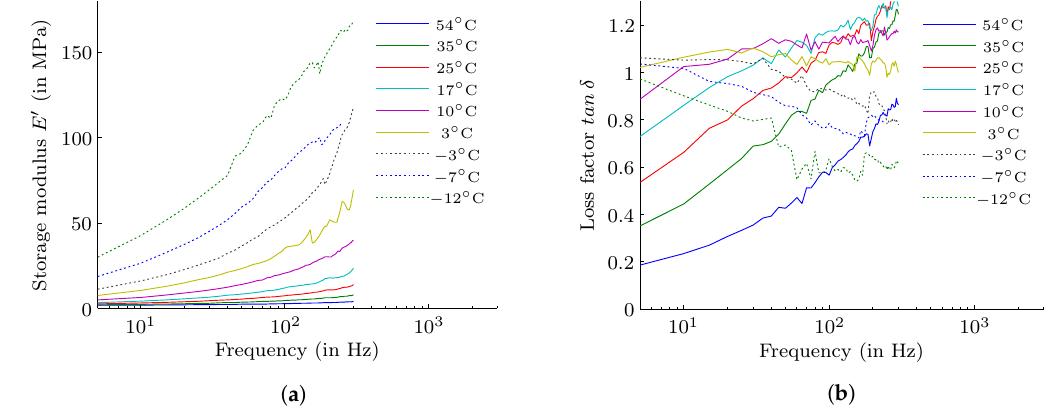
Figure 5. Storage modulus ( a ) and loss factor ( b ) of the measured isotherms.